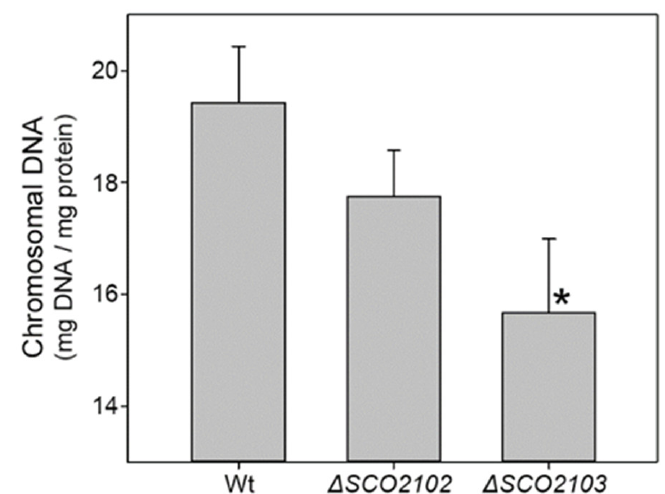
Figure 9. Chromosomal DNA at the wild-type sporulation time points in GYM cultures of the wild-type strain and the ∆ SCO2102/2103 knockout mutants. Significant difference compared to the wild-type strain is labelled by an asterisk.